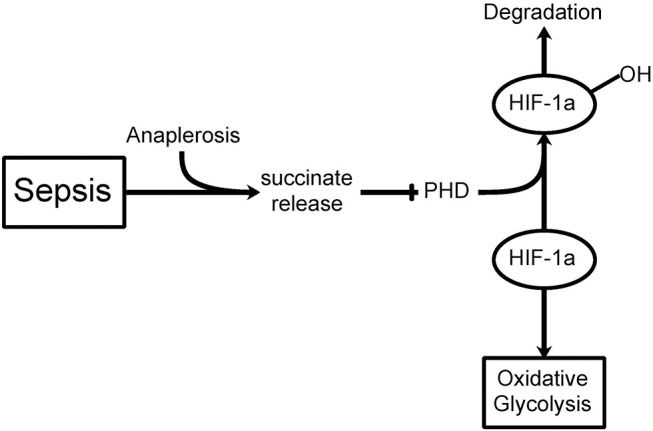
The Warburg Effect in sepsis. During septic shock, a build-up in mitochondrial succinate levels due to anaplerosis (glutamine transformation to α-ketoglutarate, a succinate precursor) is observed resulting in release into the cytoplasm. Prolyl hydroxylase (PHD) hydroxylates HIF-1α leading to its degradation. If PHD is inhibited by succinate release, then HIF-1α can inhibit the TCA cycle thereby favoring oxidative glycolysis (i.e., Warburg Effect) even when oxygen levels are sufficient.